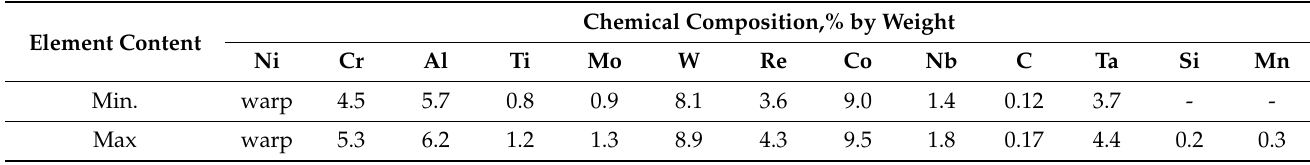
Table 1. Chemical composition of turbine blade material–nickel superalloy [29].